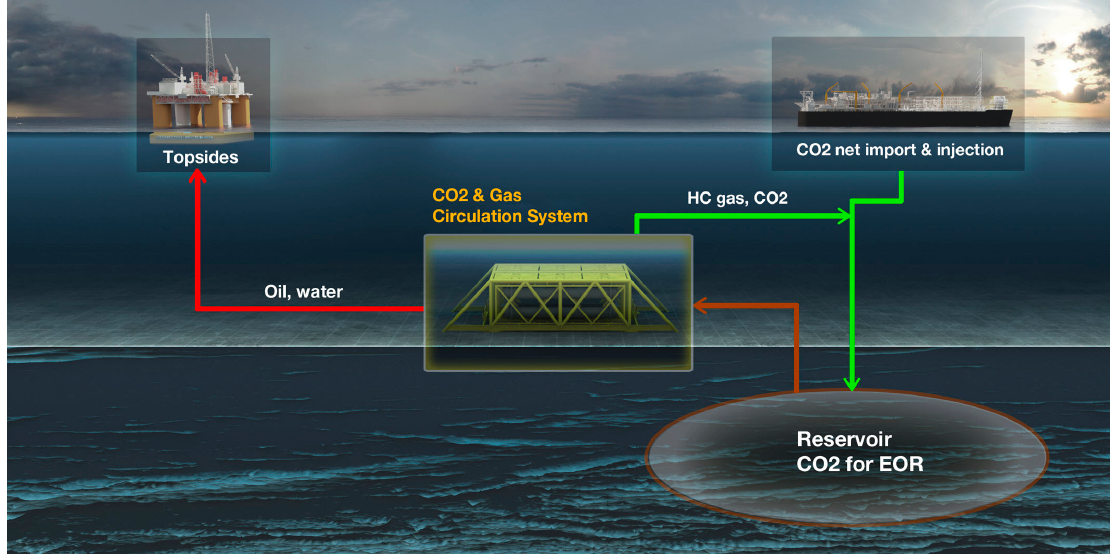
Figure 10. Concept for the subsea processing system. (courtesy Aker Solutions).